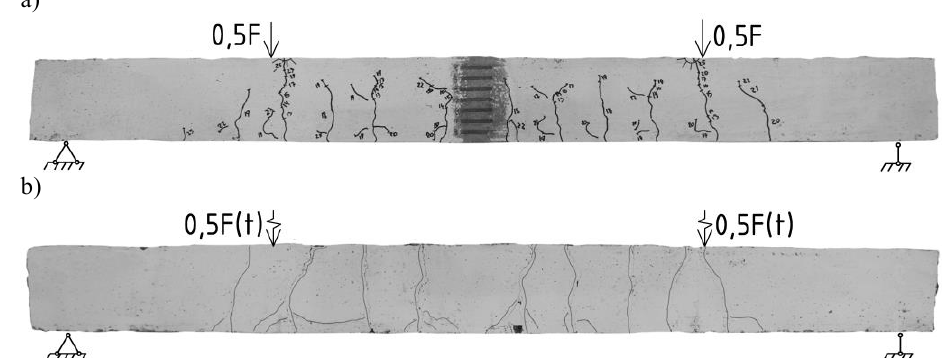
Fig. 3. Typical schemes of crack formation and fracture of bent BFC-GFRP elements under static (a) and short-term dynamic (b)